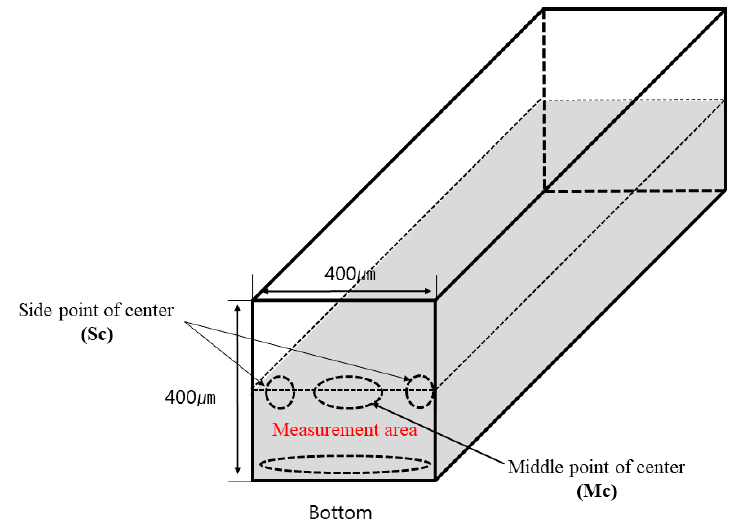
Figure 3. Square capillary tube schematic and observation position.